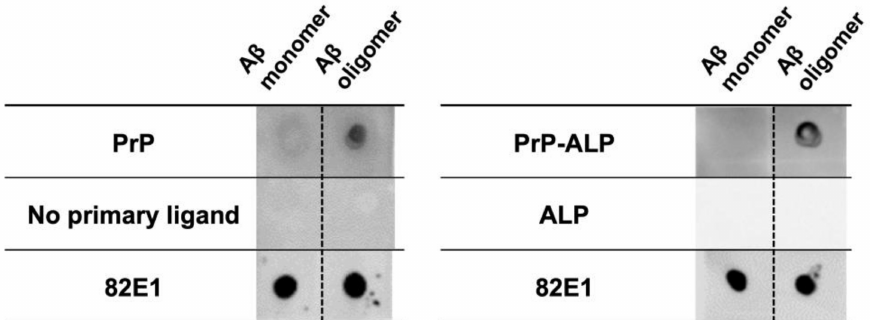
Figure 3. Dot blotting of A β using PrP, PrP–ALP, or ALP, respectively. The binding of PrP to A β was detected via StrepTag II fused to PrP, using HRP-conjugated anti-StrepTag II antibody. The PrP–ALP or ALP binding was detected based on their ALP activity.